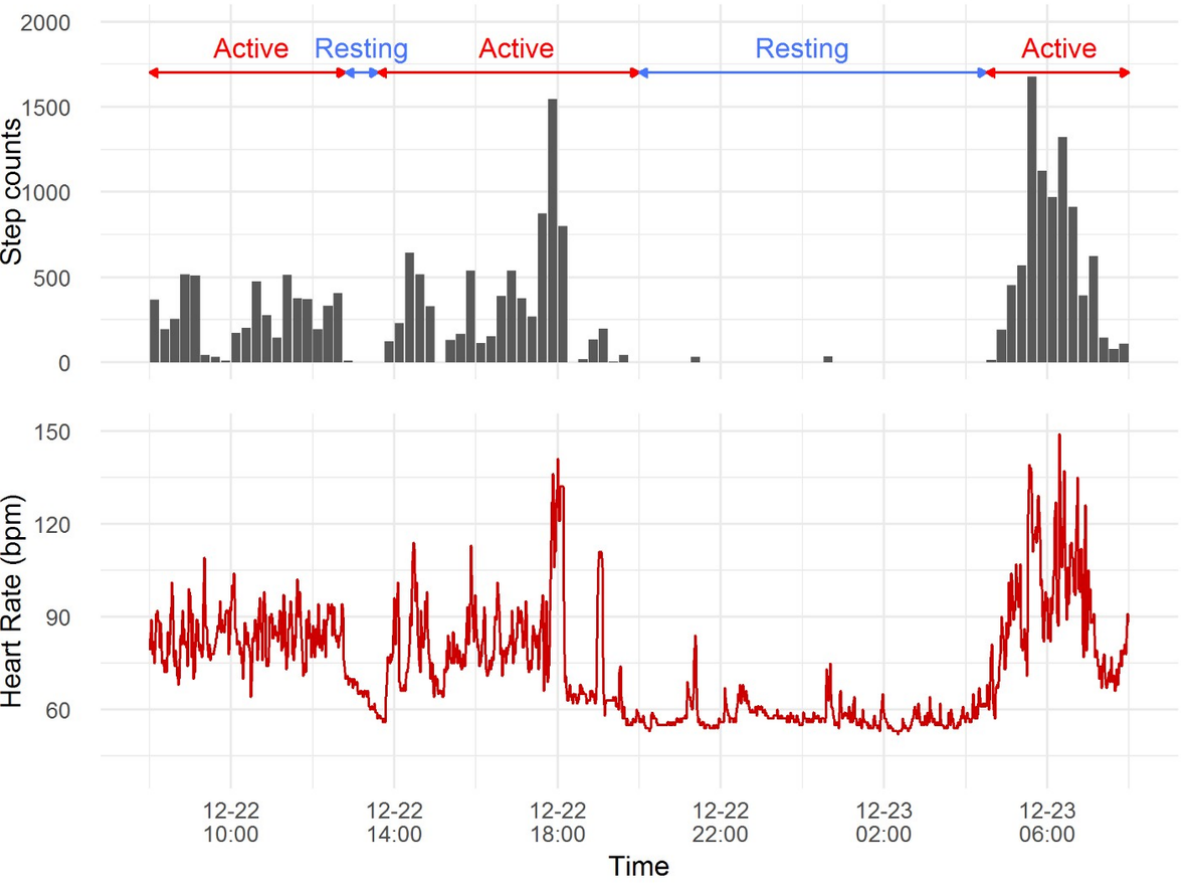
Figure 4. A 24-hour example plot of step count every 15 minutes and heart rate every 1 minute for participant EL01 from 8 AM to 7:59 AM the